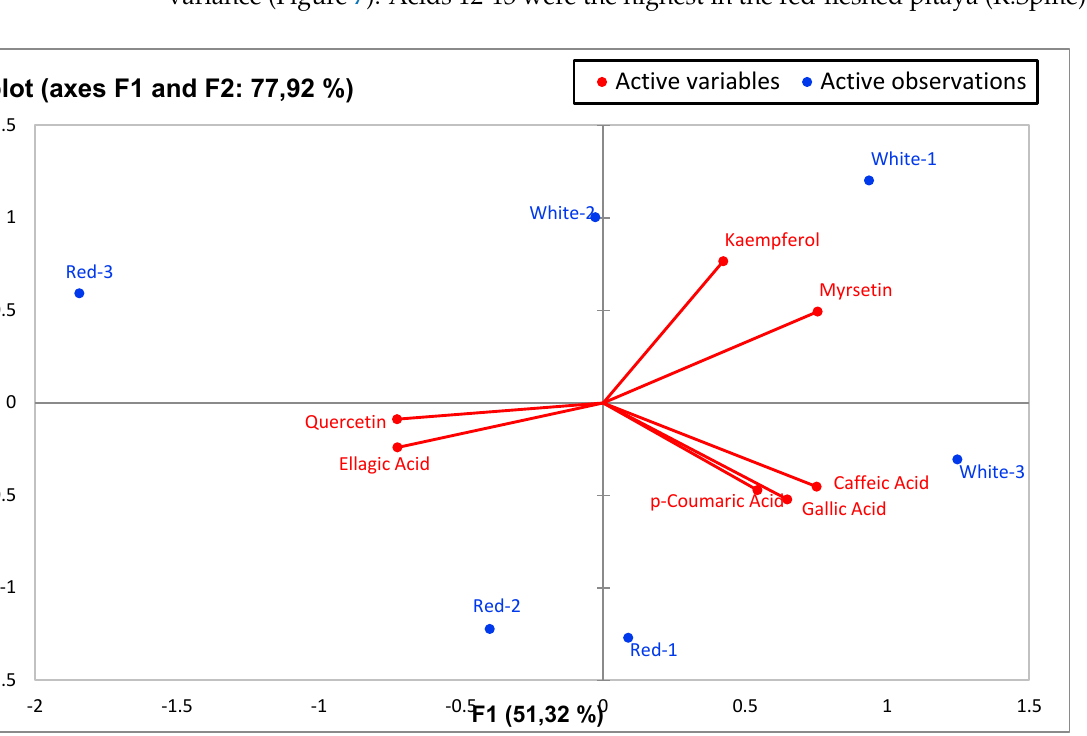
Figure 1. Biplot graph (scores and loading plots) obtained from Principal Component Analysis for phenolic compounds in red-white pitaya.